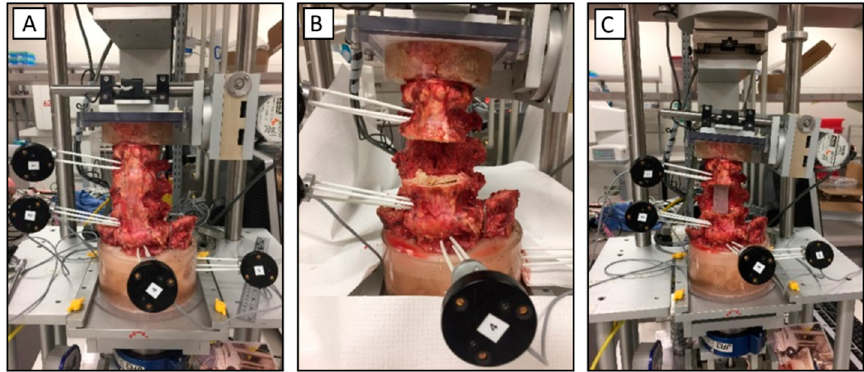
Figure 2. Kinematic motion testing setup; ( A ) intact spine; ( B ) spine after corpectomy; and ( C ) spine after placing the poly (methyl methacrylate) (PMMA) rod between L 2 and L 4.